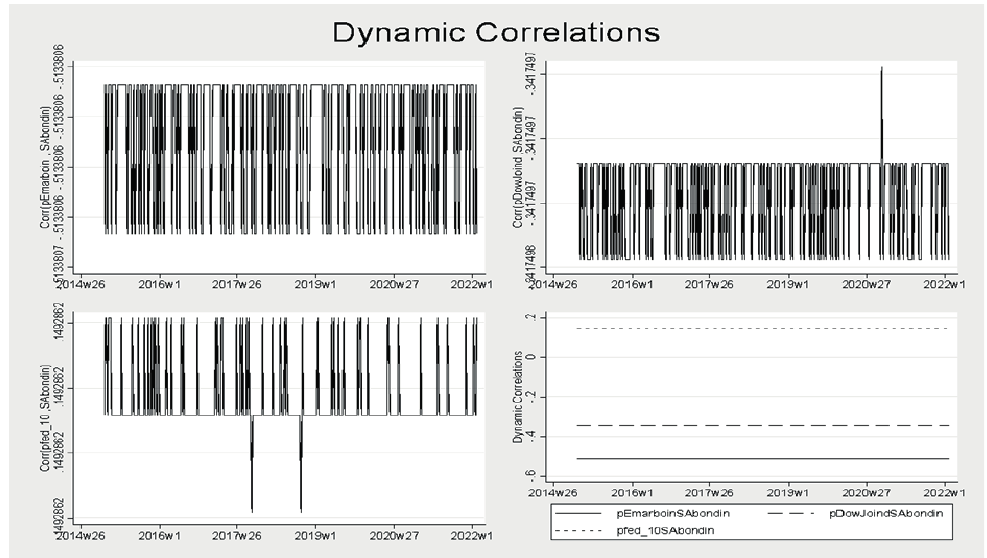
Fig. 4. CCC between the exogenous variables and sovereign bond return of South